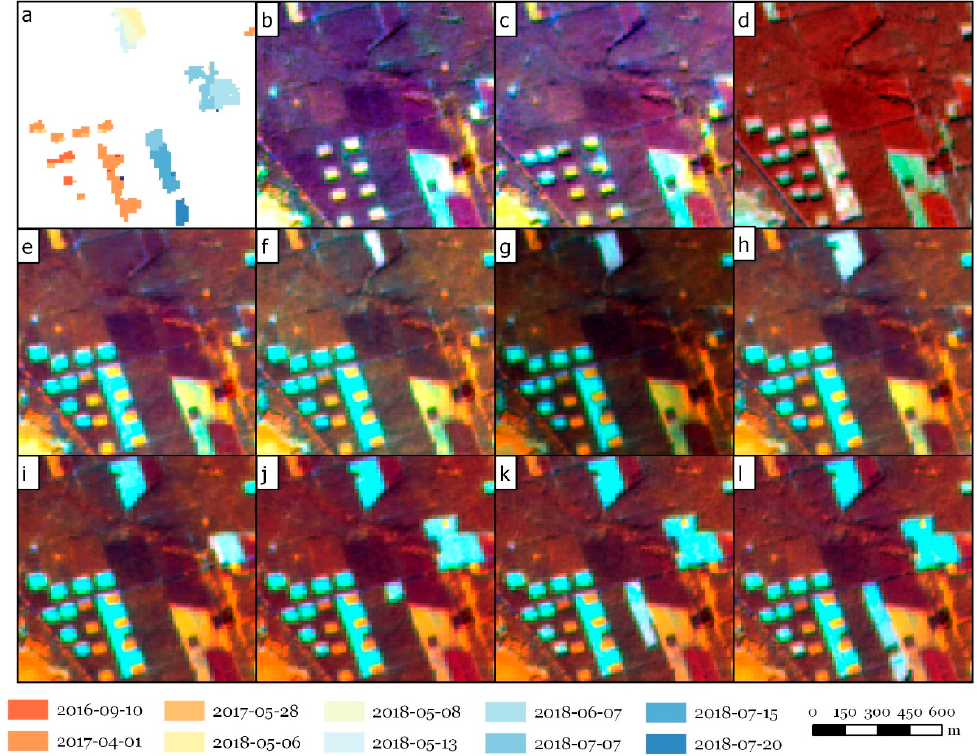
Figure 10. Part of the forest changes map based on pixel trajectory analysis ( a ) and selected Sentinel-2 time series: ( b ) 2016-07-22, ( c ) 2016-09-10, ( d ) 2017-04-01, ( e ) 2017-05-28, ( f ) 2018-05-06, ( g ) 2018-05-08, ( h ) 2018-05-13, ( i ) 2018-06-07, ( j ) 2018-07-07, ( k ) 2018-07-15, ( l ) 2018-07-20.